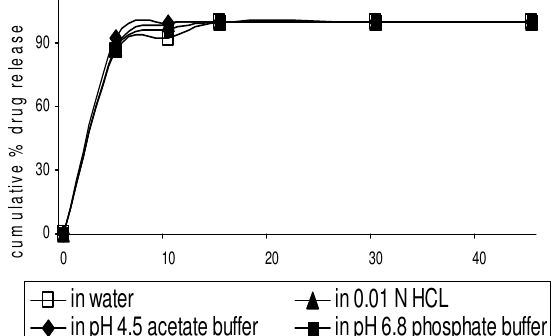
Figure 4. Drug release rate of stavudine capsules 30 mg in various pH